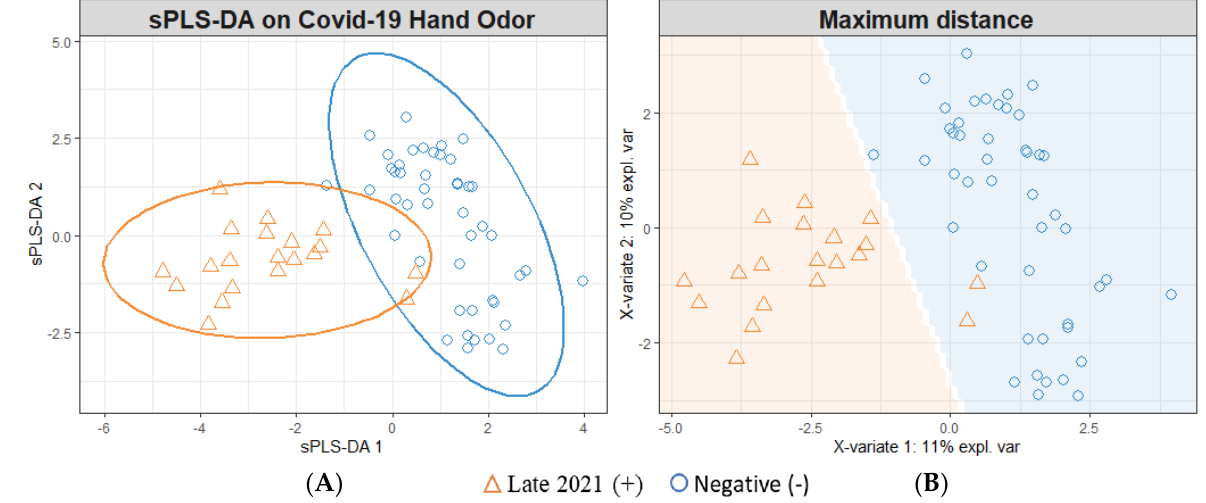
Figure 2. Late-2021 sPLS-DA Model; (+) Late-2021 Hand Odor Samples vs. ( − ) SARS-CoV-2 Samples. ( A ) Individual sample plot; ellipses = 95% CI. ( B ) Individual sample plot; background delineates class assignment.